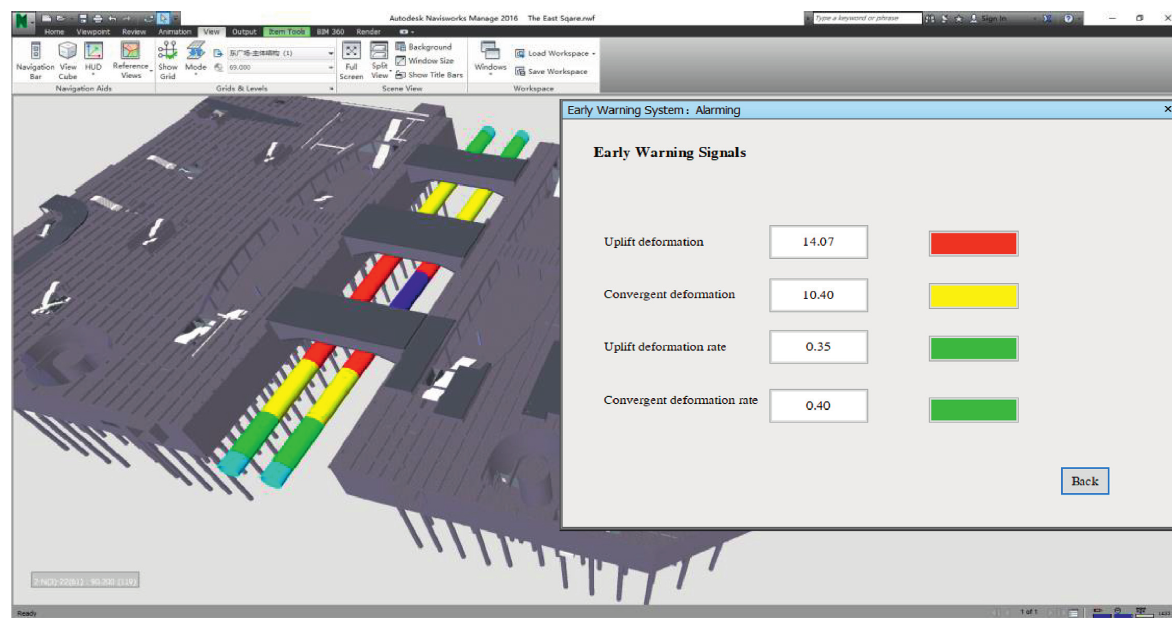
Figure 15: Overview of risk indicators on 8